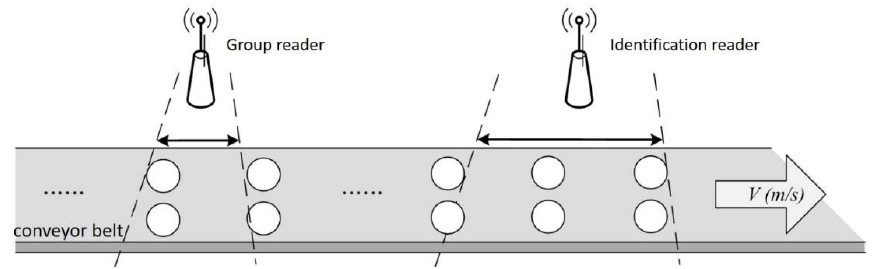
Figure 5. Schedule-based anti-collision protocol (SAC) algorithm setup .